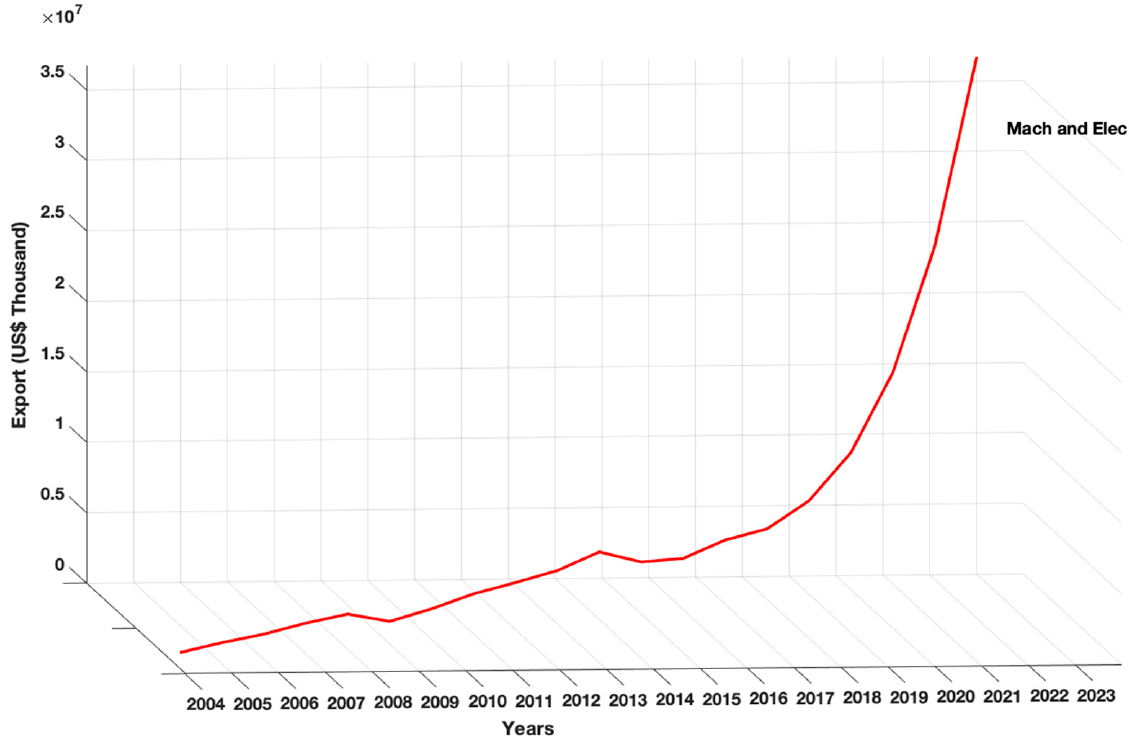
Figure 7. Development of the machinery and electrical machinery sector covering 2004–2023.